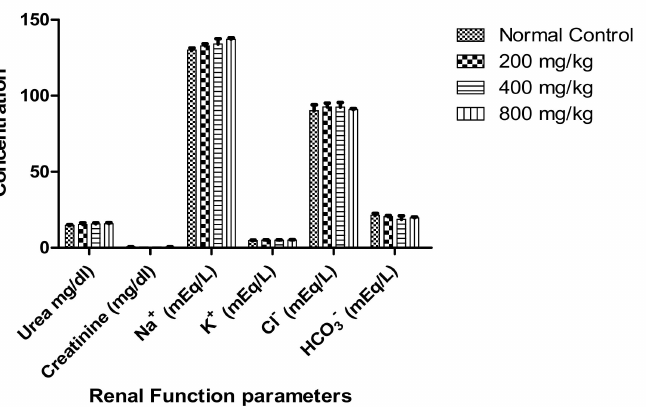
Figure 4. Effect of aqueous C. pepo leaf extract on kidney function parameters of male rats. Values represent the mean ± SD for n = 6. Cl − , Chloride ion; Na + , Sodium ion; K + , Potassium ion; and HCO 3 − , Bicarbonate.